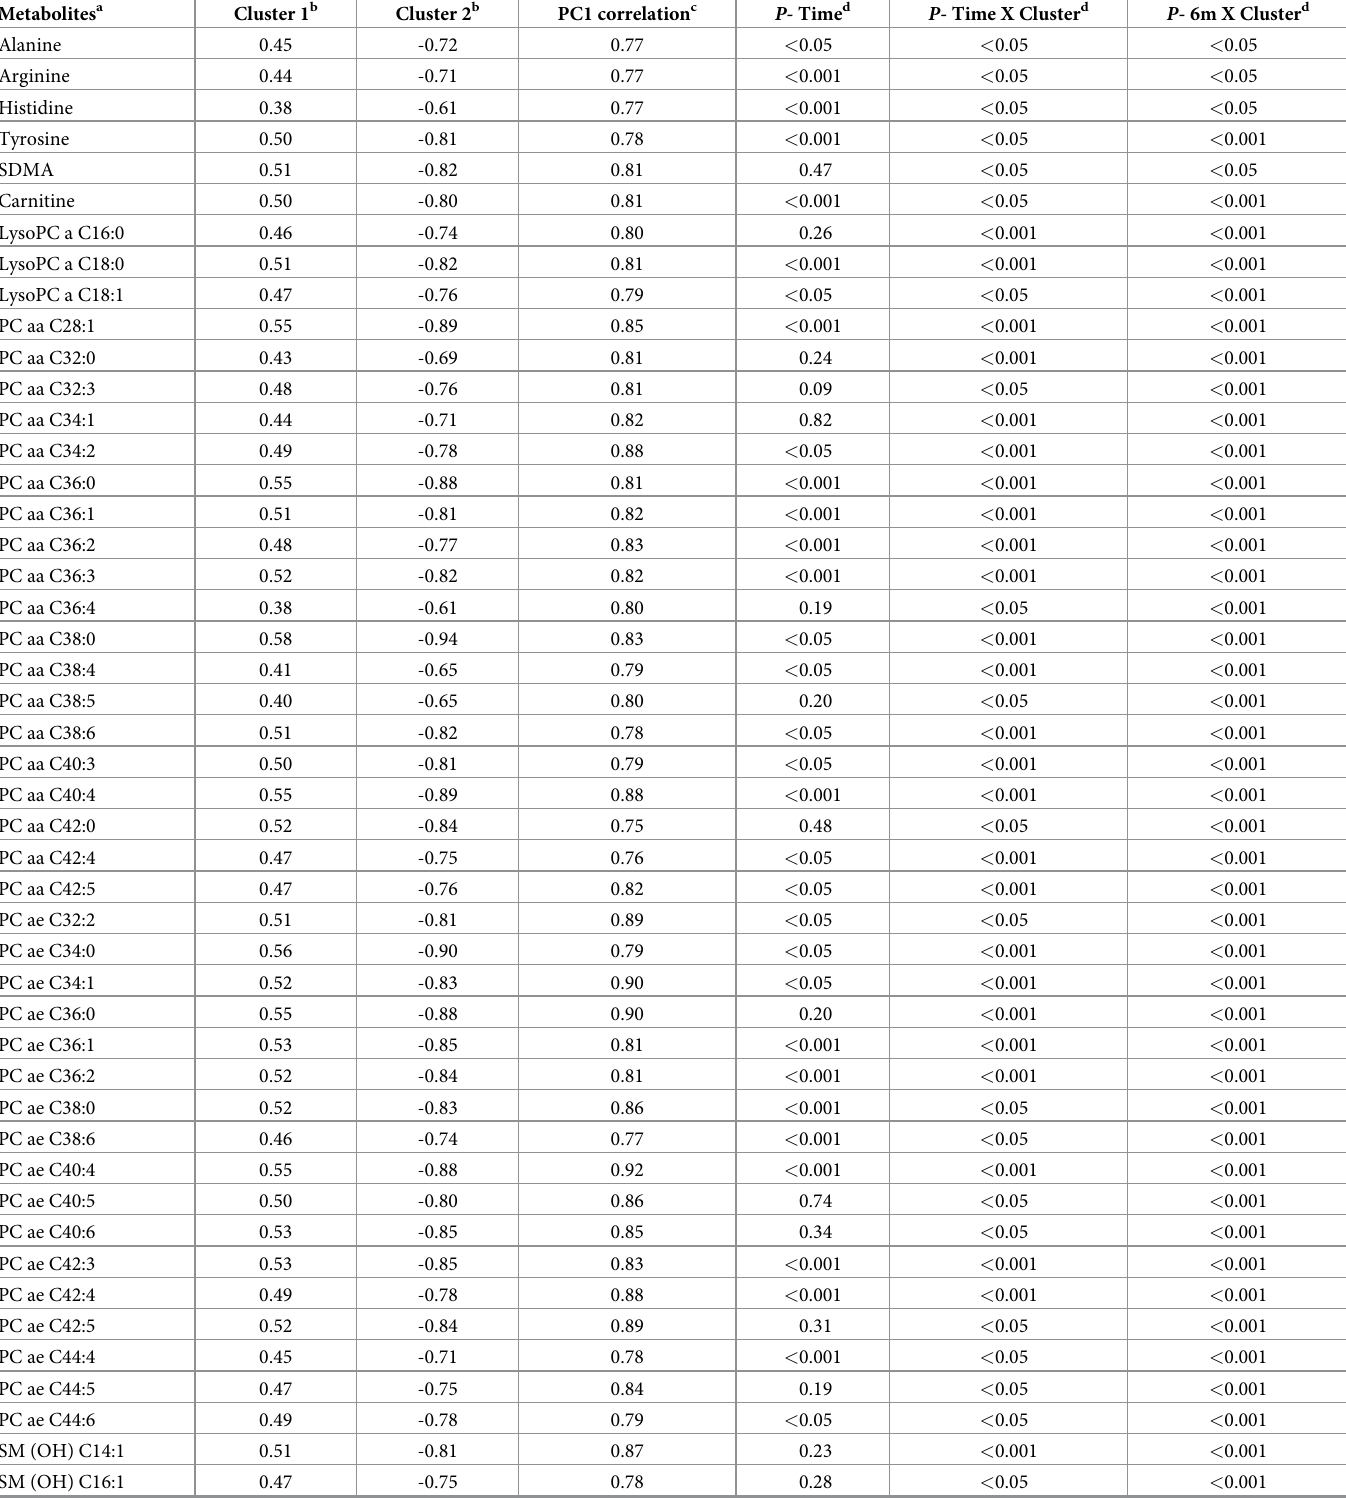
Table 1. The most discriminating metabolites for K-means at 6-month increment versus baseline (sorted by family and alphabetical order). Metabolites